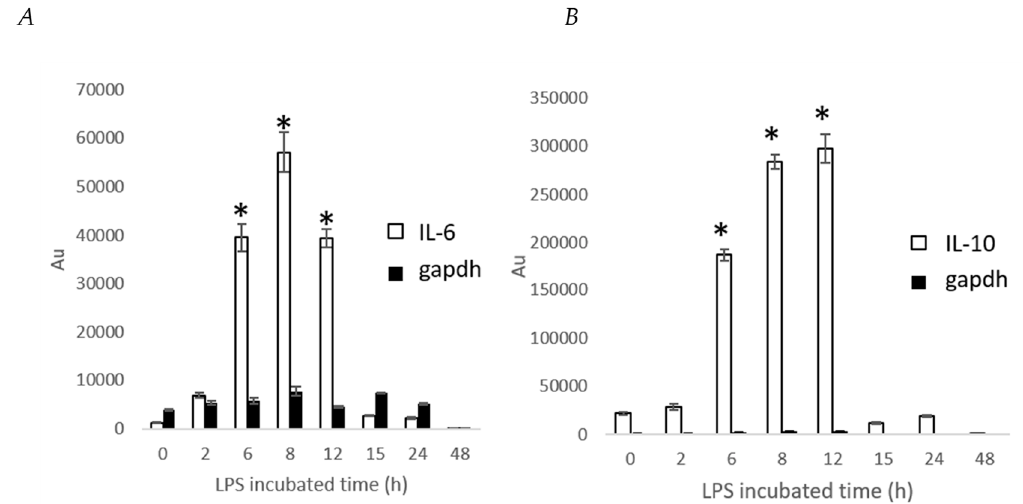
Figure 3. Expression of IL-6 and IL-10 in LPS treated stable cell using a microplate luminometer. Stimulation of stable cells with LPS 100 ng / mL for various time periods. ( A ): IL-6 and gapdh luciferase reporter activity. ( B ): IL-10 and gapdh luciferase reporter activity. Each value represents the mean ± SD ( n = 4). * p < 0.001 versus the LPS group.